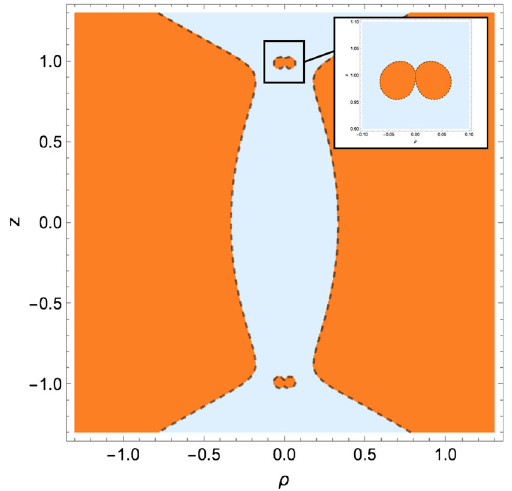
Fig. 1 Ergoregion (shaded orange region) of the NHEK2 black hole solution for M = 1, as a consequence of the presence of such regions in the original stationary extreme BBHs geometries. The black holes are located at ρ = ˆ ρ H = 0 , z = ˆ z H = ± 1. A more detailed diagram, close to one of the black holes appears in the upper right corner. The dashed line corresponds to the boundary where ∂ ˆ t is